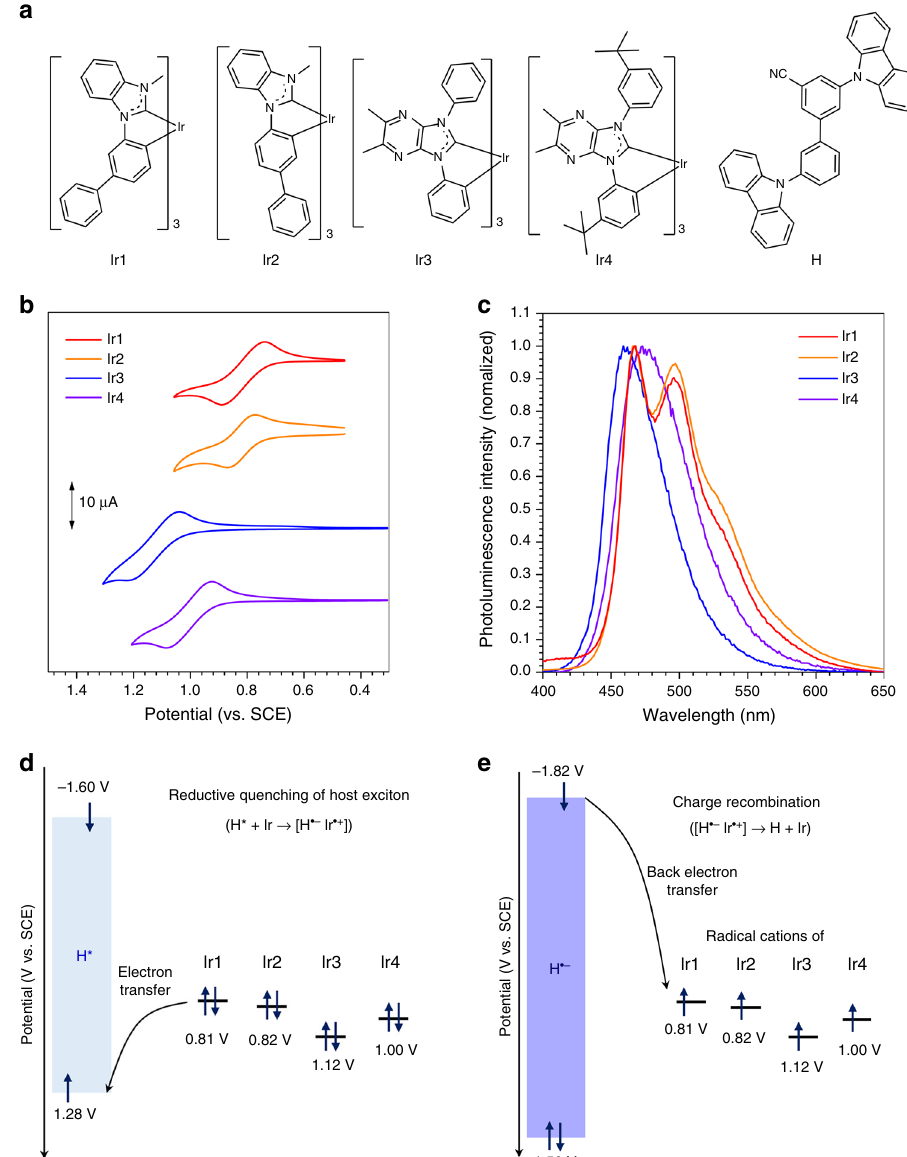
Fig. 2 Prediction of the formation of radical ion pairs. a Chemical structures of the blue-phosphorescent dopants (Ir1 − Ir4) and the host molecule (H). b Cyclic voltammograms of the Ir dopants. Conditions: a standard three-electrode cell assembly consisting of a Pt disc working electrode, a Pt wire counter electrode, and an Ag/AgNO 3 pseudo reference electrode were employed. Solutions of 2.0 mM compounds in THF were deaerated prior to taking the measurements. c Photoluminescence spectra of 10 μ M Ir dopant solutions (THF, deaerated). Photoexcitation wavelengths used were 341 nm (for Ir1), 340 nm (for Ir2), 396 nm (for Ir3), and 400nm (for Ir4). d Comparison of the electrochemical potentials of the host and dopants involved in reductive quenching of the host exciton. e Comparison of the electrochemical potentials of the host and dopants involved in charge recombination within a pair of the radical anion of the host and the radical cation of the